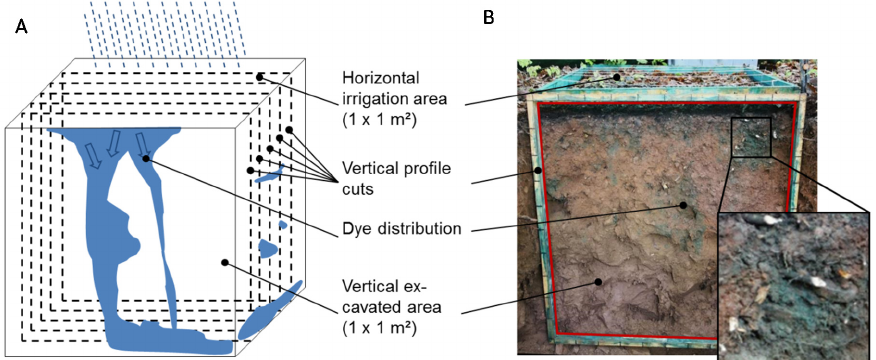
Figure 1. Scheme of tracer experiments ( A ): Dye application at the soil surface (1 m²), covering overnight, and excavation of five vertical (1 m²) profile cuts (example on the right ( B )). The black framed enlargement shows staining of flow pathways along roots and stone surfaces.